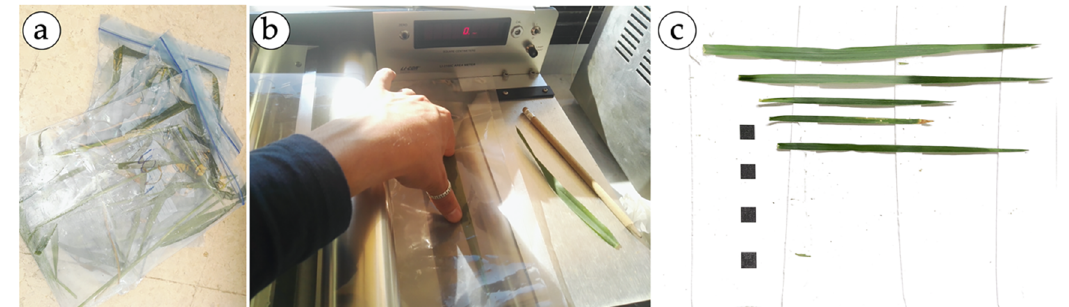
Figure 2. Data collection process for building the allometric relationship. Leaves stored in plastic bags to be transported in a cooler ( a ); measurements of the unitary leaf area using the LICOR-3100 ( b ); and leaves placed on a sheet of paper with the squares in the background (c) .